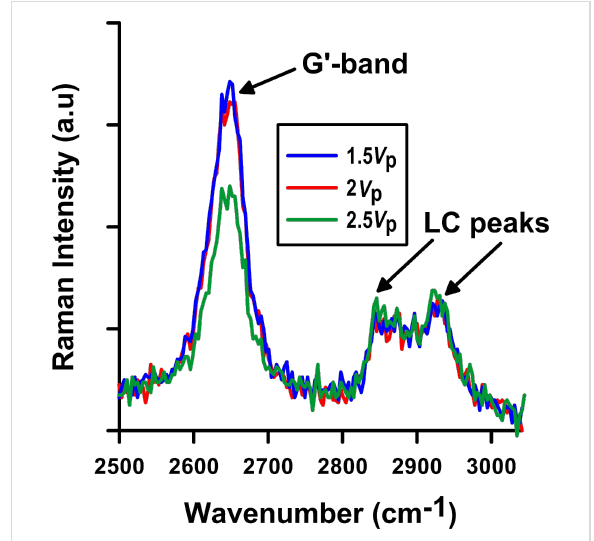
Figure 9: Raman Intensity evolution of the G’-band and LC peaks with voltage. The SWCNT threshold voltage is visible between 2 V p and 2.5 V p